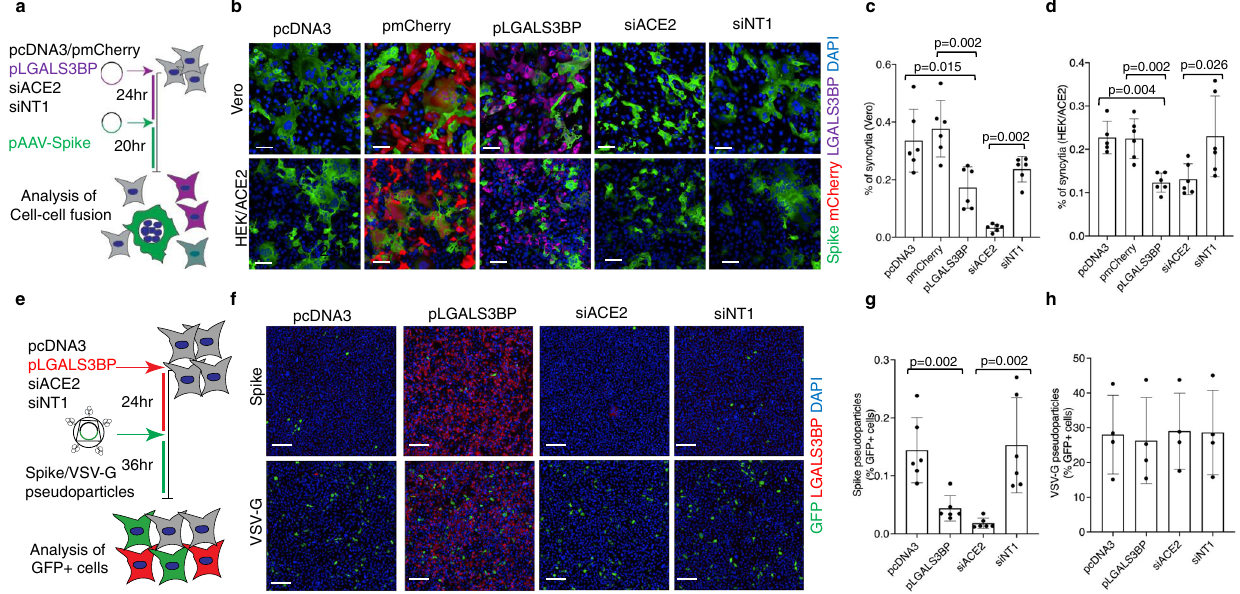
Fig. 8 LGALS3BP overexpression impairs SARS-CoV-2 spike-mediated syncytia formation and cellular uptake of SARS-CoV-2 spike-pseudoparticles. a Schematic representation of the SARS-CoV-2 spike-mediated cell-cell fusion assay. b – d Vero and HEK293-ACE2 cells were transfected either with pcDNA3 (plasmid backbone), pmCherry (plasmid coding mCherry), pLGALS3BP (plasmid coding LGALS3BP), siACE2 (siRNA targeting ACE2), or siNT1 (non-targeting siRNA), followed by transfection of pAAV-Spike (plasmid coding SARS-CoV-2 spike) 24 h later. After 20 h, cells were stained with anti- LGALS3BP (violet), anti-Spike (green), and DAPI for nuclei (blue). Representative images are shown in ( b ), and quanti fi cations are shown in ( c) for Vero cells and in ( d ) for HEK293-ACE2 cells. Data (mean ± standard deviation; n = 6; Mann – Whitney U test) are plotted as the percentage of fused cells (syncytia) normalized to the total number of cells. Scale bars in ( b ) represent 100 µ m. e Schematic representation of the SARS-CoV-2 spike/VSV-G pseudoparticle transduction assay. f – h HEK293-ACE2 cells were transfected either with pcDNA3, pLGALS3BP, siACE2, or siNT1, followed by the addition of spike- or VSV-G pseudoparticles carrying a GFP reporter 24 h later. After 36 h, cells were stained with anti-LGALS3BP (red), anti-GFP (green), and DAPI for nuclei (blue). Representative images are shown in ( f ) and quanti fi cations are shown in ( g ) for spike-pseudoparticles (mean ± standard deviation; n = 6; Mann – Whitney U test) and in ( h ) for VSV-G pseudoparticles (mean ± standard deviation; n = 3). Data are plotted as the percentage of GFP-positive cells normalized to the total number of cells. Scale bars in ( f ) represent 200 µ m. All statistical analyses are